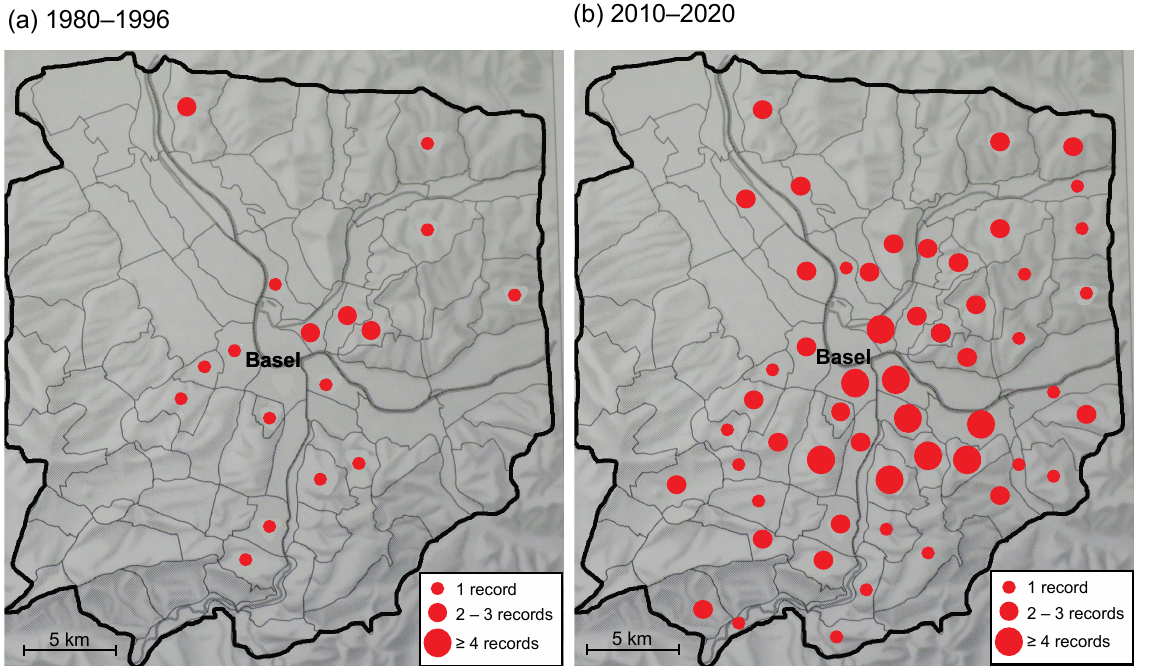
Figure 3. Frequency of Lamium galeobdolon subsp. argentatum records in 92 mapping areas in the region of Basel (Switzerland) in the years 1980–1996 ( a ), and in 2010–2020 ( b ). Data 1980–1996 from Brodtbeck et al. [32].